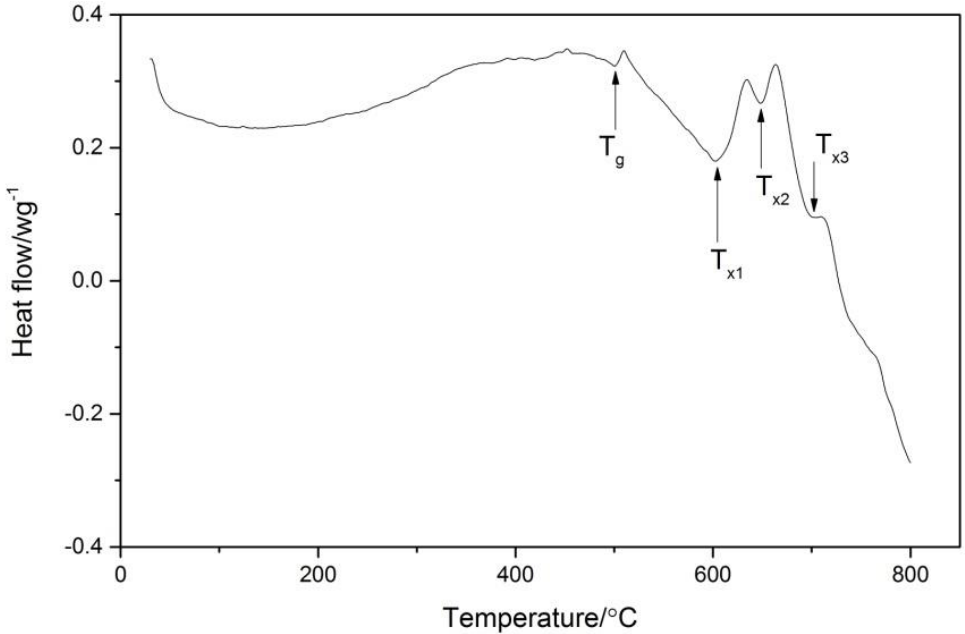
Figure 4. DSC curve of Fe-based metallic glass.